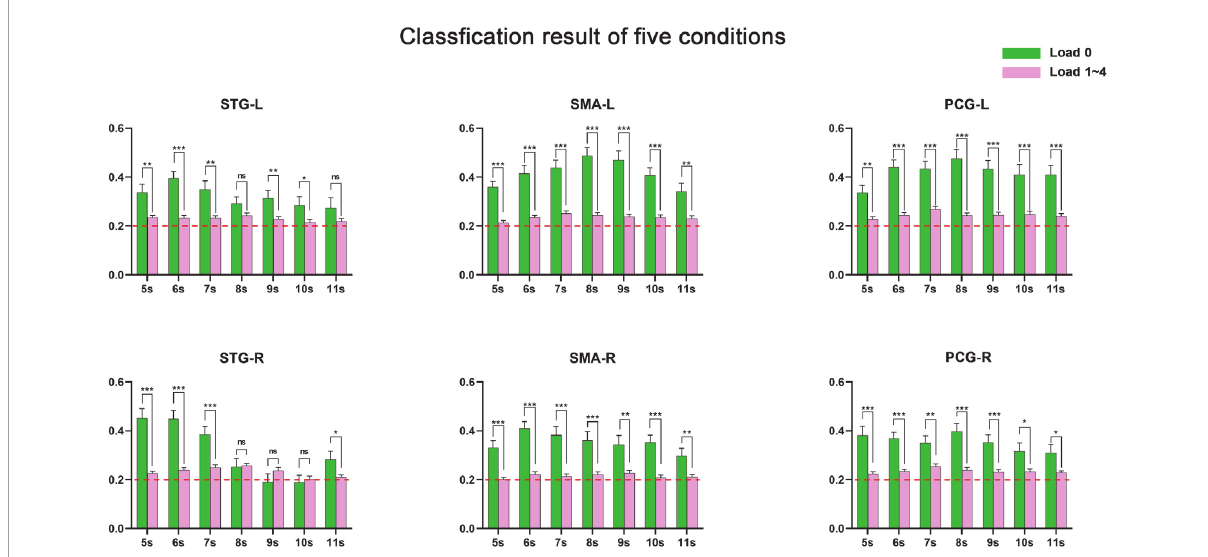
FIGURE8 Accurate rates (number of correctly identified trials/total number of trials) of the classification of the five categories. The accurate rates of load 0 in 5 ∼ 11 s are significantly higher than other conditions. ∗ Means p < 0.05; ∗∗ means p < 0.01; and ∗∗∗ means p <